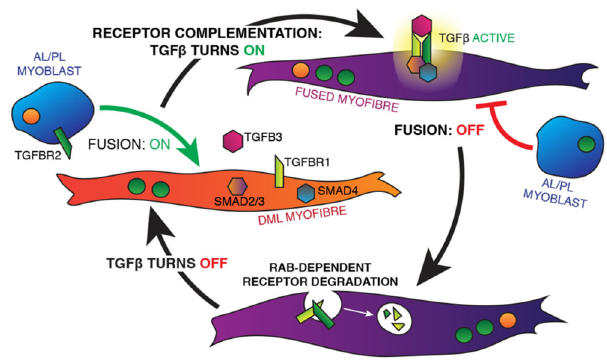
Fig. 6 A model describing the receptor complementation mechanism. Prior to fusion, myocytes originating from the DML (in orange) express the ligand TGFB3, the effectors SMAD 3, & 4 and the receptor TGFBR1. They are competent to fuse. Myoblasts originating from the posterior or anterior borders of the somite (in blue) express TGFBR2. Upon fusion of myoblasts to DML-derived myocytes, membrane merging of the fusion partners allow the activation of the TGF β pathway by a receptor heterodimer complementation mechanism (in purple), ultimately leading to a temporary inhibition of fusion of another myoblast. The process of fusion is likely reinitiated after RAB-mediated receptor degradation.